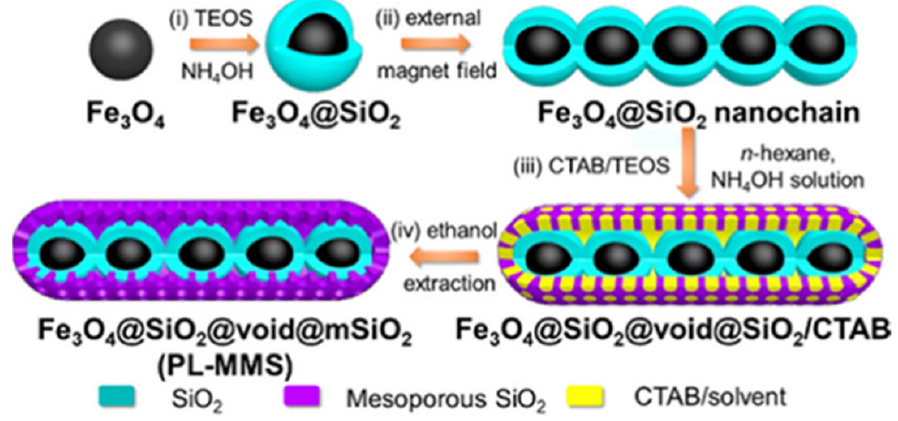
Figure 5. Synthesis Procedures of PL-MMS Nanochain: (i) Sol–Gel Coating of Silica; (ii) Magnetic- Field-Guided Assembly; (iii) Mesostructured CTAB/Silica Interface Assembly onto the Nanochain; (iv) Surfactant Removal. Reproduced with permission from [60], the American Chemical Society, 2020.